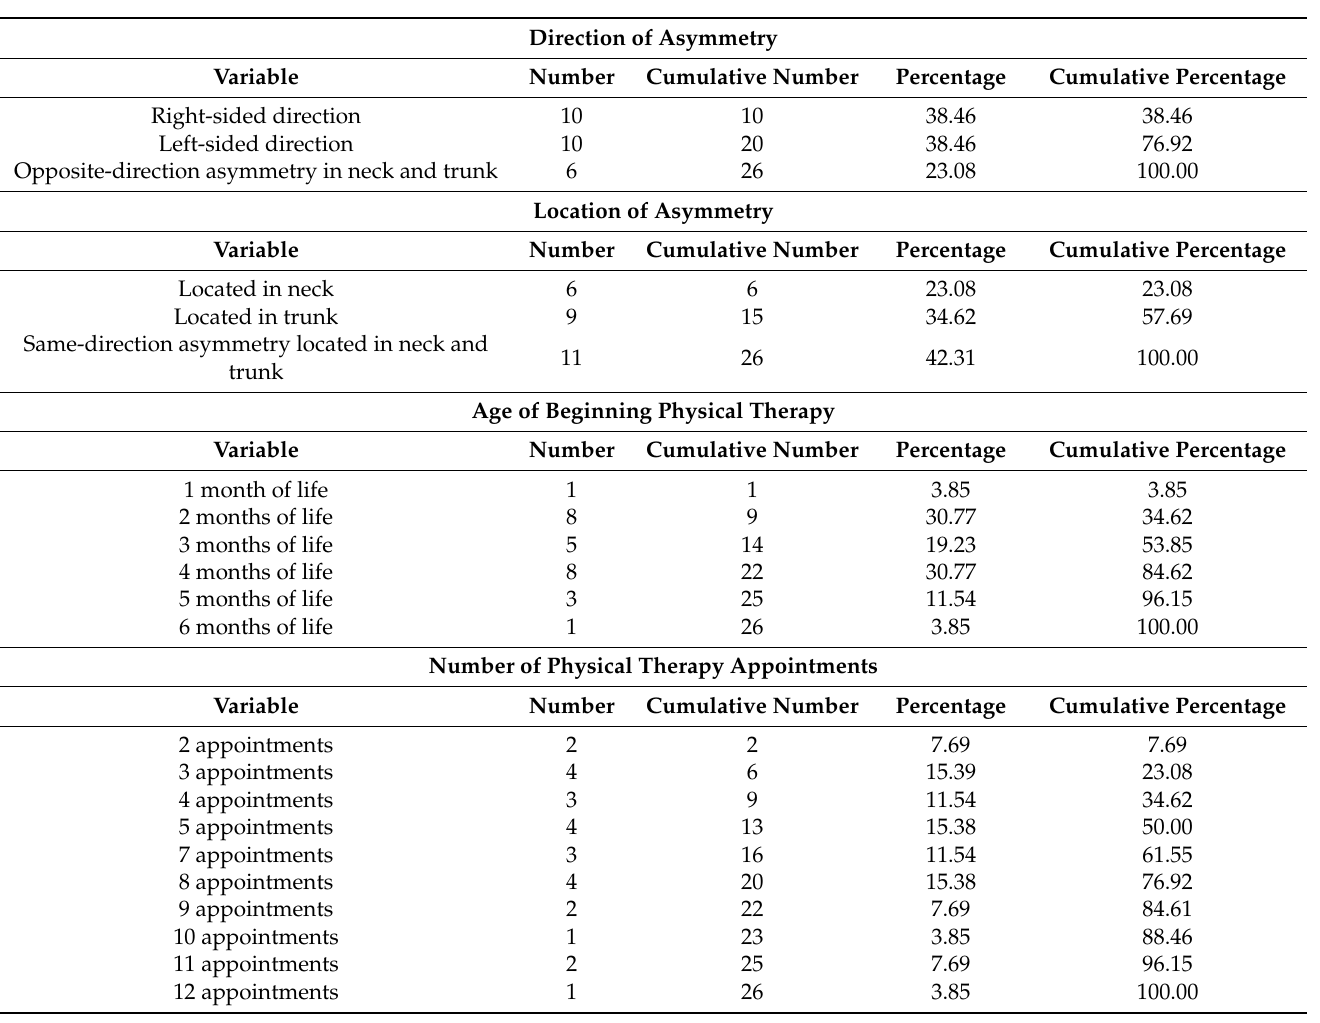
Table 1. Cross-tabulation of infant idiopathic asymmetry for the study group comprising girls.